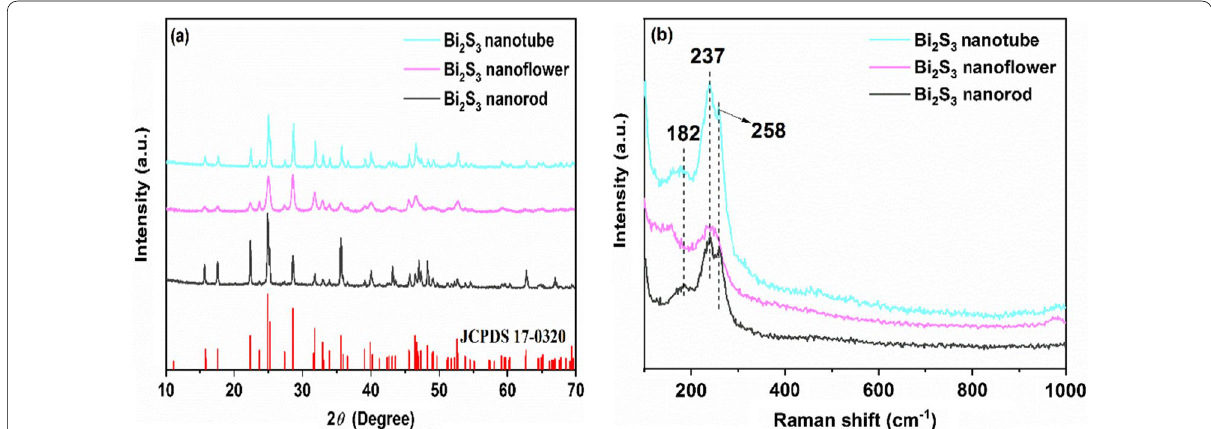
Fig. 1 a XRD patterns and b Raman spectra of Bi 2 S 3 with different